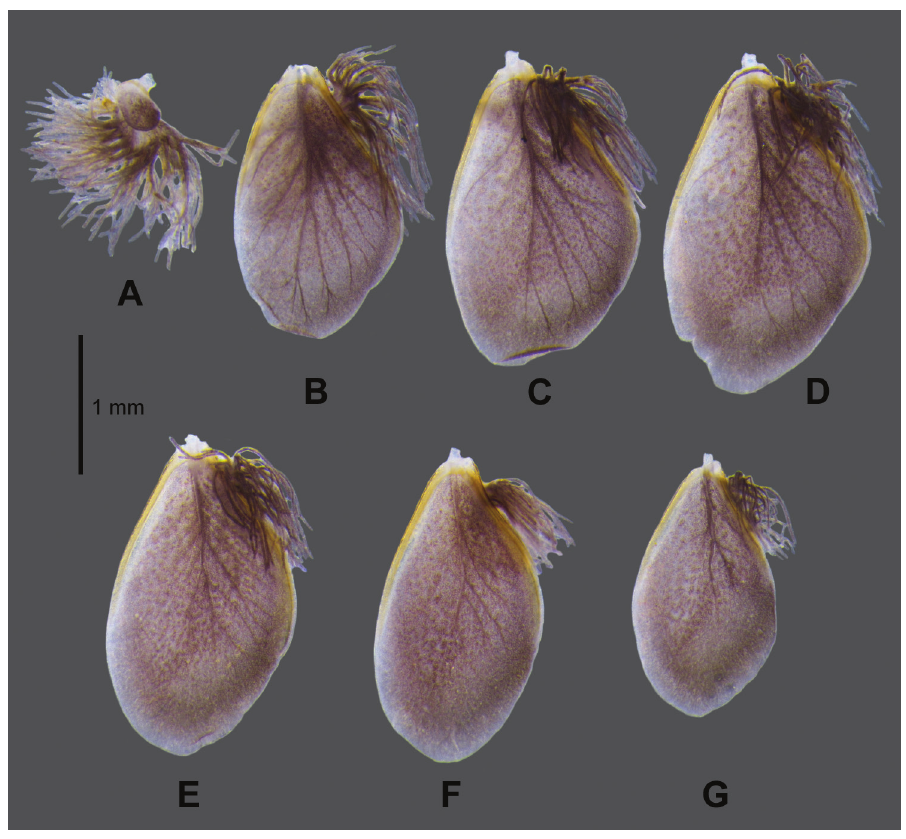
F gill VI G gill